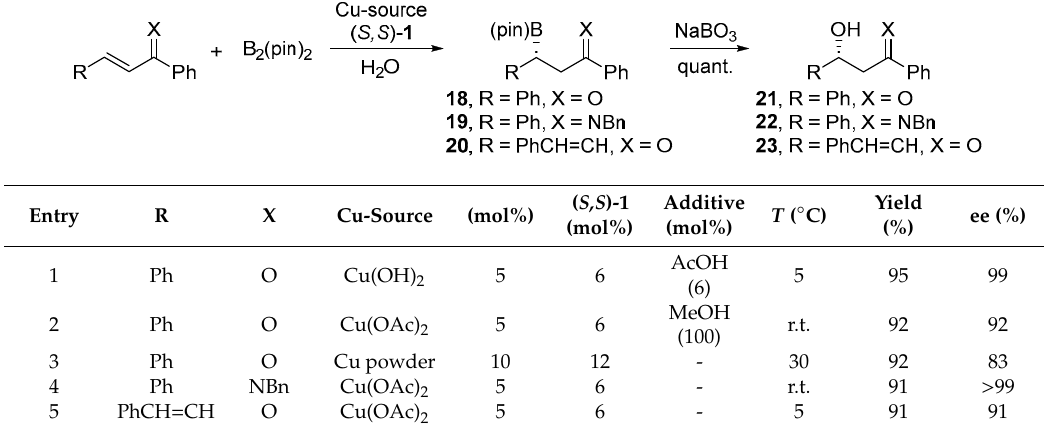
Table 5. Conjugate boron addition to α , β -unsaturated compounds.